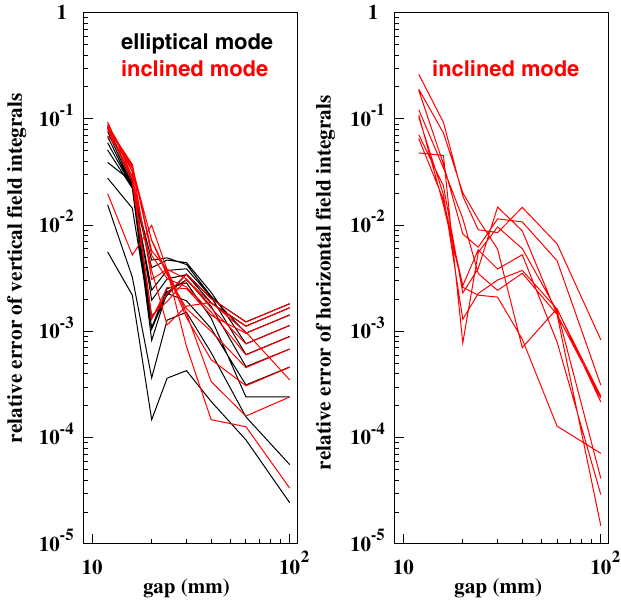
FIG. 9. Relative error of the field integral prediction for various gaps and shifts and for the elliptical and the inclined mode as evaluated from the shim model (see text). The absolute error is defined by the difference between the field integrals from the model and field integrals from RADIA . The relative errors are defined by the ratio between the absolute errors and the maximum field integral value at 20 mm gap and shift ¼ 0 : 5 (cid:3) 0 for theverticalfield integrals andshift ¼ 0 : 25 (cid:3) 0 for the horizontal field integrals.